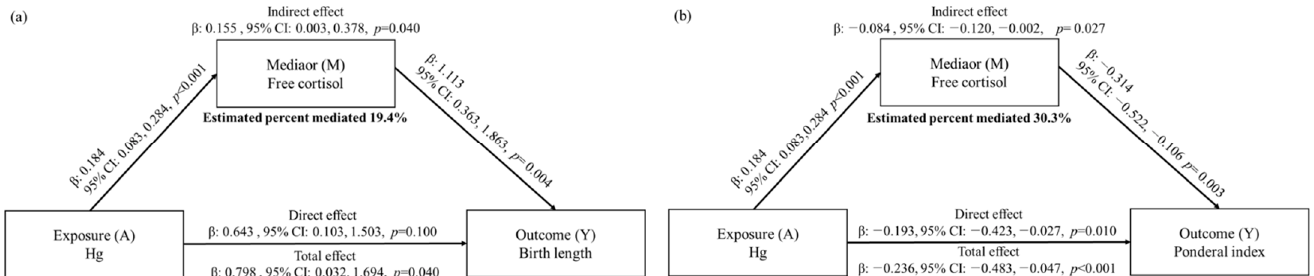
Figure 4. Mediation effect of free cortisol on associations of maternal urinary Hg with ( a ) birth length and ( b ) the Ponderal index. Percent mediated was derived from the indirect effect ( β )/(direct effect ( β ) + indirect effect ( β )) × 100.